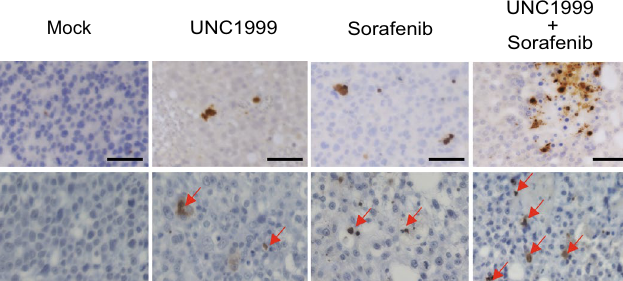
Figure 6. Xenograft transplantation using NOD/SCID mice and histopathological examination of xenograft tumors. ( A ) Tumor growth curve of the recipient mice treated with sorafenib and/or UNC1999 (repeated measures ANOVA, * p < 0.05). ( B ) Representative images of recipient mice treated with sorafenib and/or UNC1999 6 weeks after the transplantation. ( C ) Xenograft tumors were subjected to Hematoxylin and eosin staining and immunohistochemical staining. Scale bar = 50 µm. ( D ) Immunostaining of CASP3 and TUNEL assay. Arrows indicate TUNEL-positive cells. Scale bar = 50